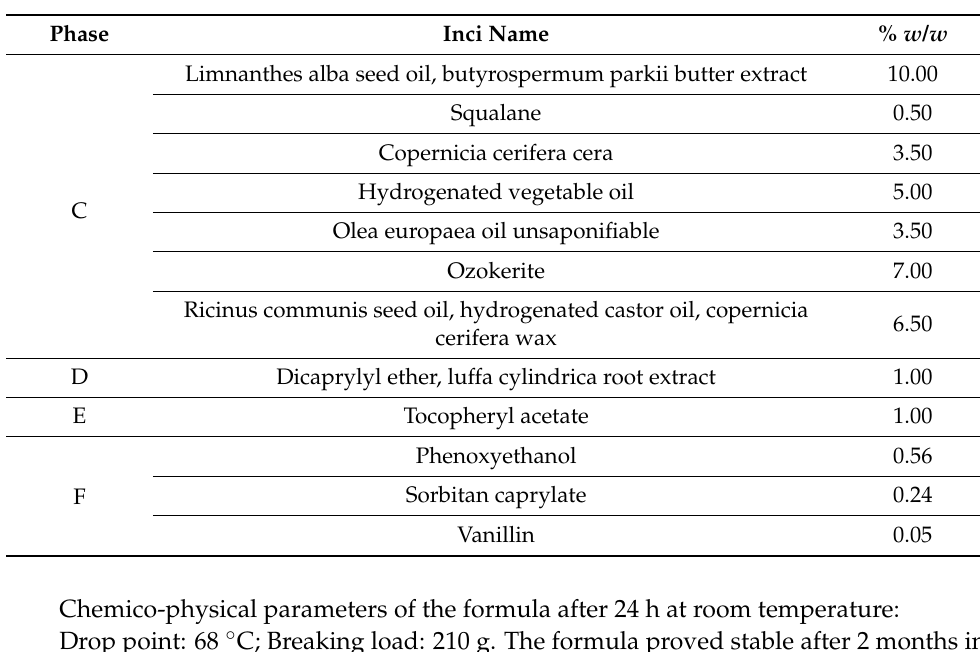
Table 13. Evaluation of the initial formula vs. Ref. 1/21/1B.